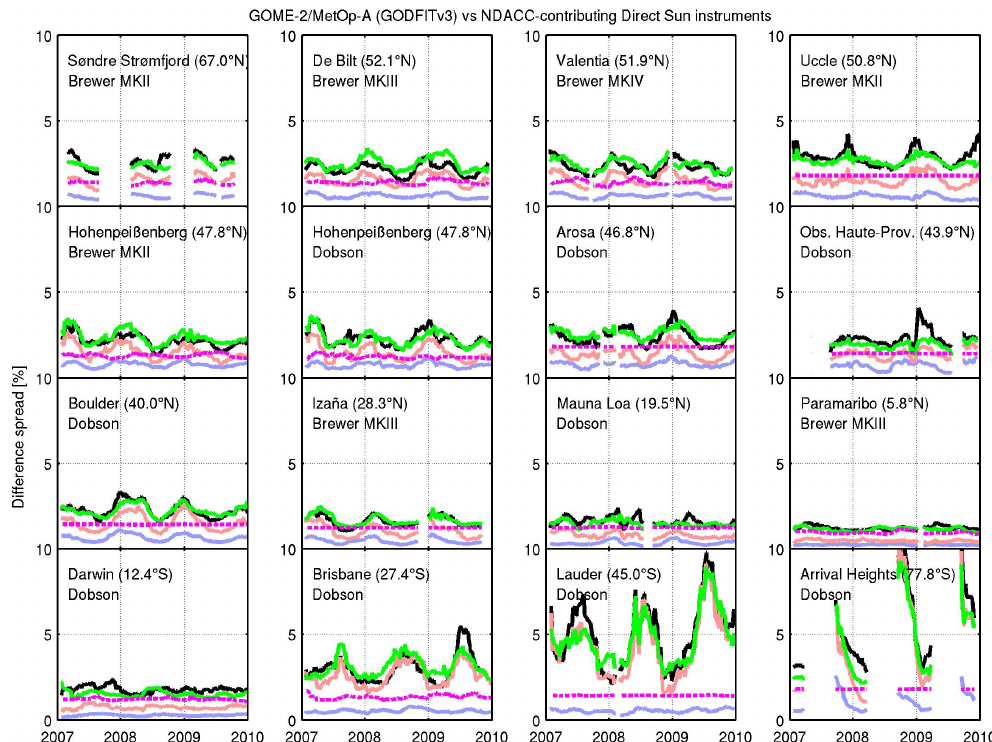
Figure 14. Spread of the differences (3-month running 16–84% interquantiles) between GOME-2/MetOp-A observations and correlative direct-sun measurements (Brewers and Dobsons) from all NDACC network stations with sufficient co-locations during this period. The legend and the definition of comparison spread are the same as in Fig. 6. Note that the magenta line, representing the combined measurement uncertainty, is based on the revised estimates of the random satellite measurement uncertainty (Sect.